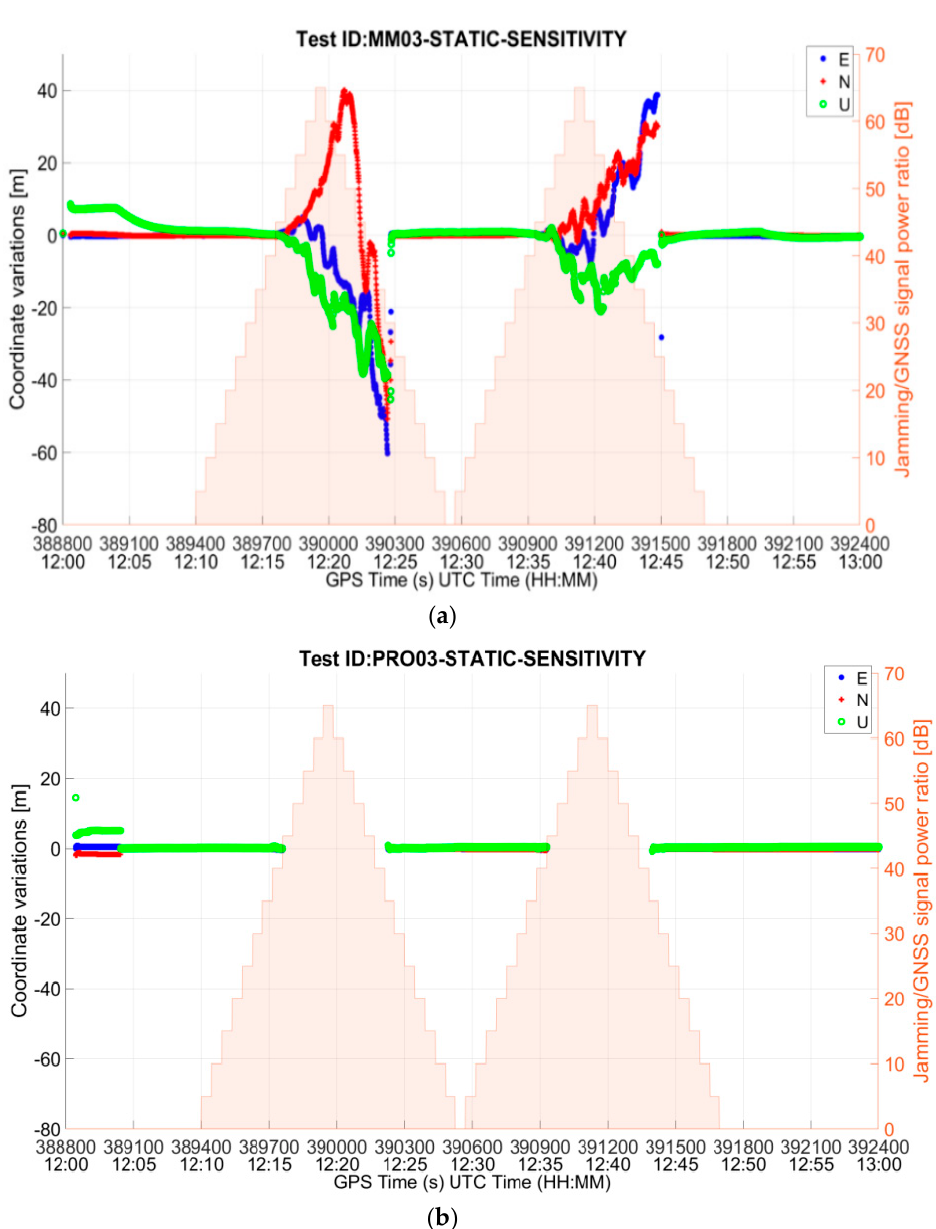
Figure 8. East-North-Up deviations for ( a ) MM RUT and ( b ) PRO RUT in the presence of threat signature 03 when C/N 0 default settings are used in both the receivers.